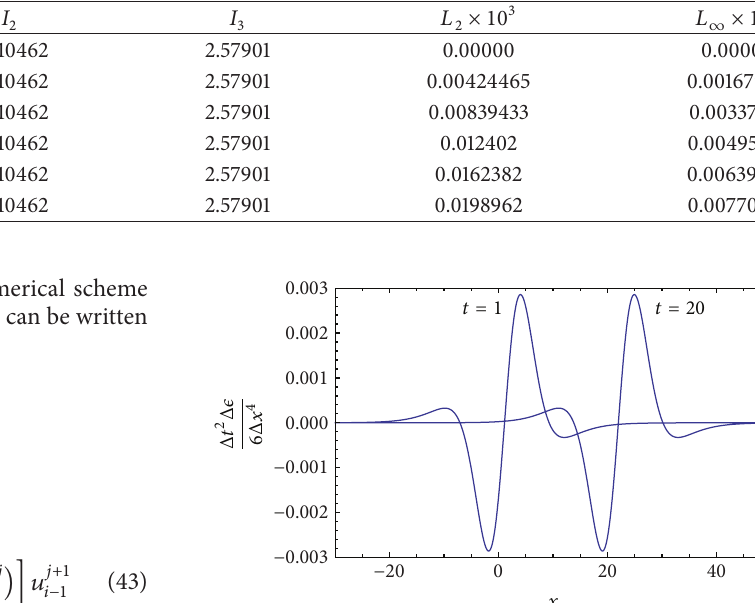
Figure 3: Plot showing the behaviour of the second-order modified equation (31) after substituting the single solitary wave solution to the RLW equation (8) with (31) taking V = 0.1 and 𝑥 0 = 0 .